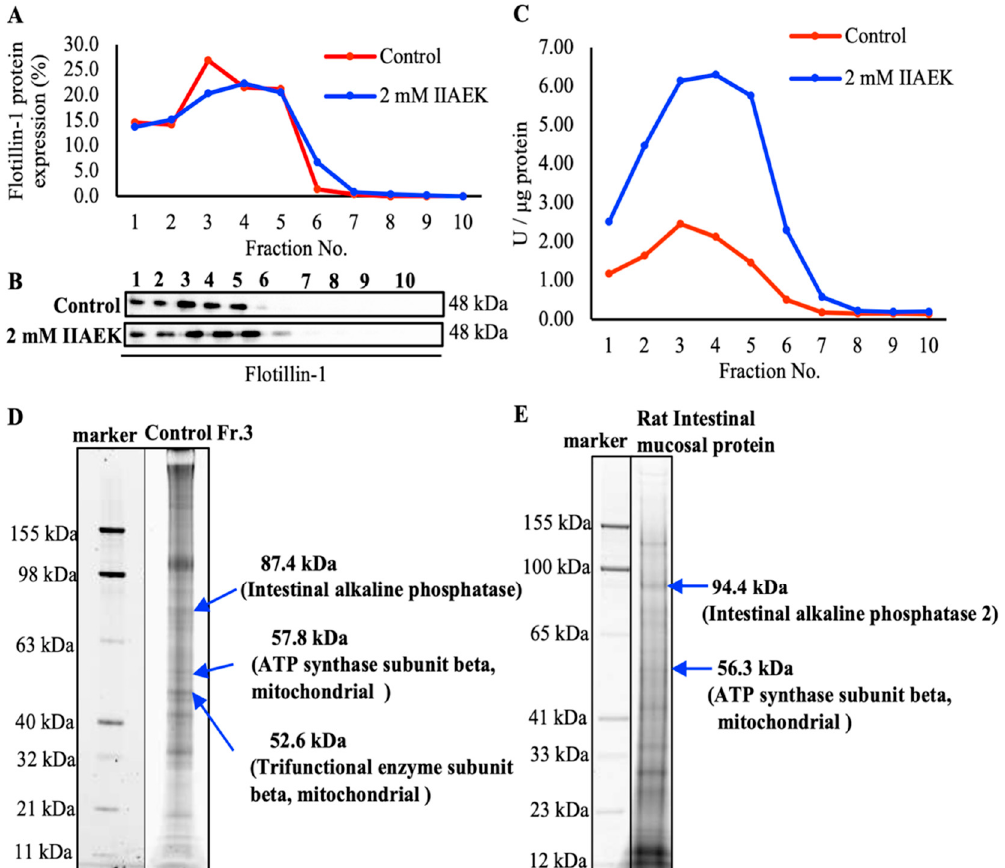
Figure 3. Extraction of intestinal lipid raft fractions from Caco-2 cells and photoaffinity labeling by IIXEK for the lipid raft fraction and rat intestinal mucosal protein. ( A , B ) Protein level of the lipid raft marker flotilin-1 in each fraction. ( C ) Alkaline phosphatase (AP) activity in each fraction. ( D ) Photoaffinity labeling of intestinal lipid raft proteins by IIXEK. The intestinal lipid raft fraction (Fr. 3) containing 250 μ M IIXEK was irradiated with UV for 30 min for photoaffinity labeling. Subsequently, the fraction containing the fluorescent substance, rhodamine, which was added by a click reaction, was separated on SDS-PAGE. ( E ) Photoaffinity labeling of rat intestinal mucosal protein fractions by IIXEK. We collected the small intestinal mucosal proteins of 5-week-old male Wistar rats. The membrane protein fractions, which were derived from rat small intestinal mucosa, were collected with EB2B of TM-PEK and made into rat small intestinal mucosal fractions. Photoaffinity labeling was performed in the same way as described in Figure 3D.